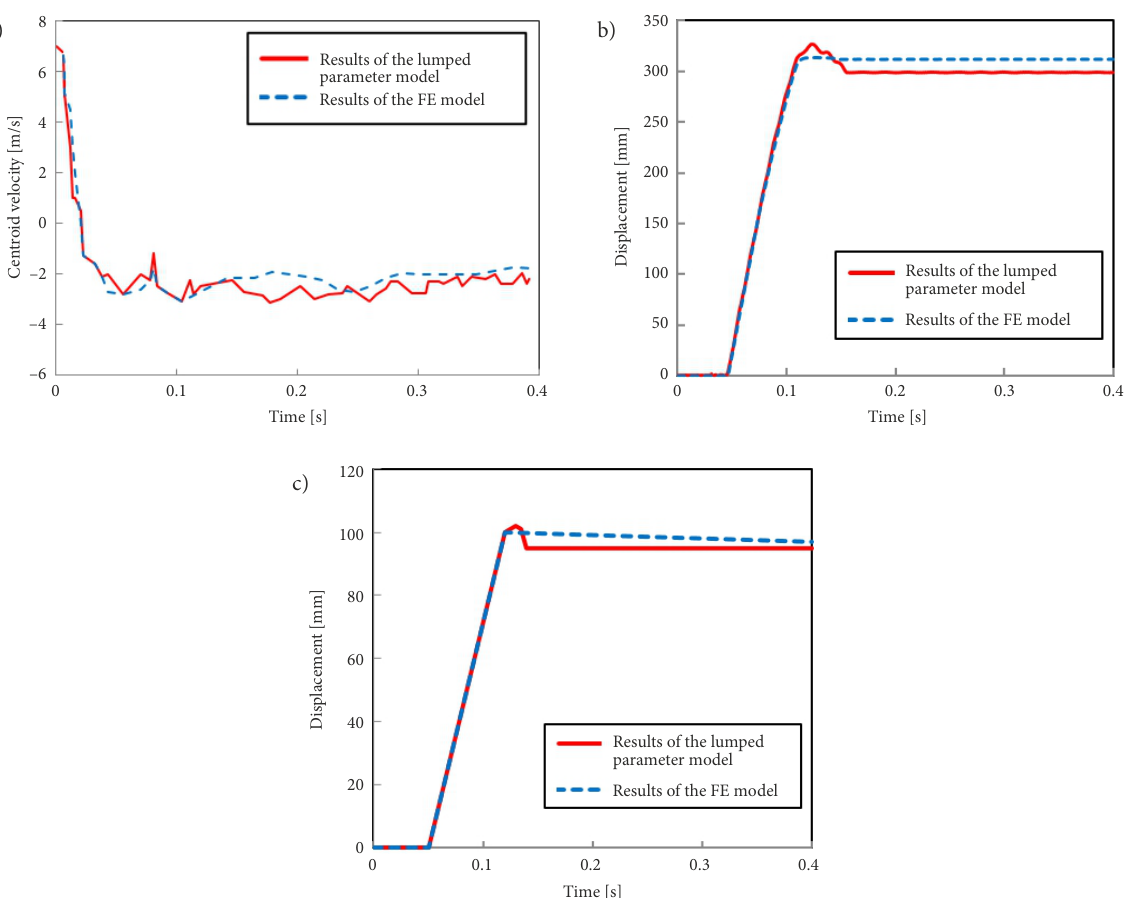
Figure 25. Comparison of the two methods: a – speed change in the gravity center in the two models; b – displacement of the underframe in the two models; c – displacement of the roof in the two